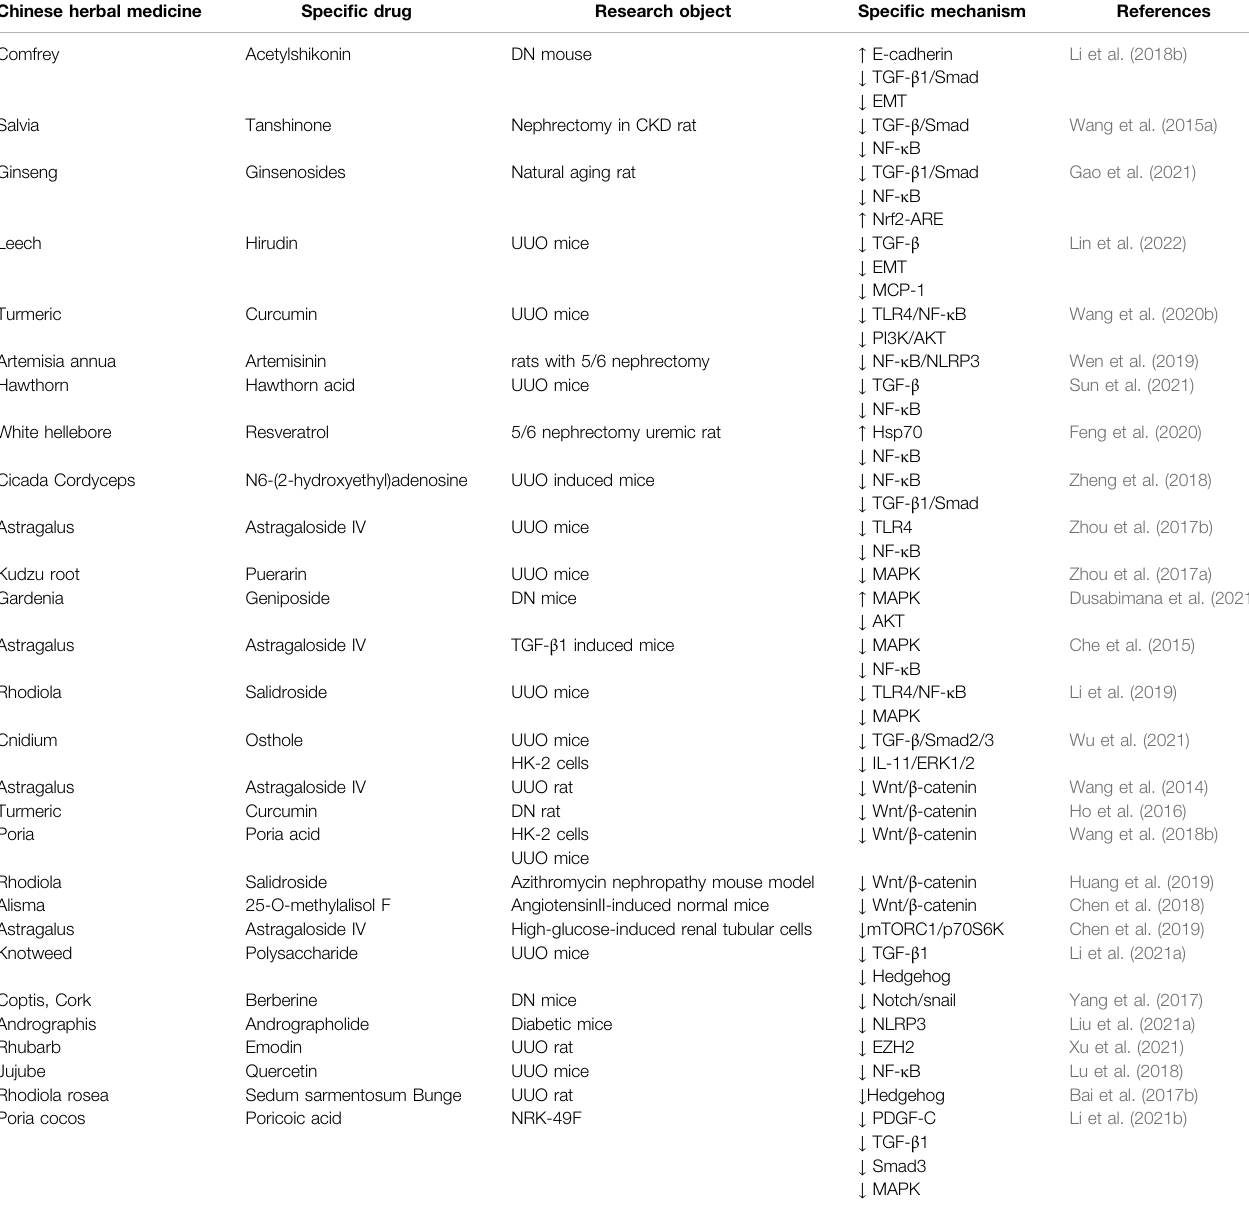
TABLE 2 | Summary of Chinese herbal medicines that improve RIF-related mechanisms Chinese herbal